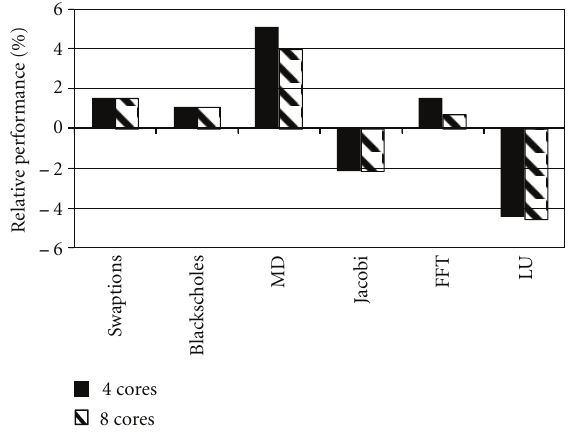
Figure 5: Performance comparison among RC#1 and RC#2